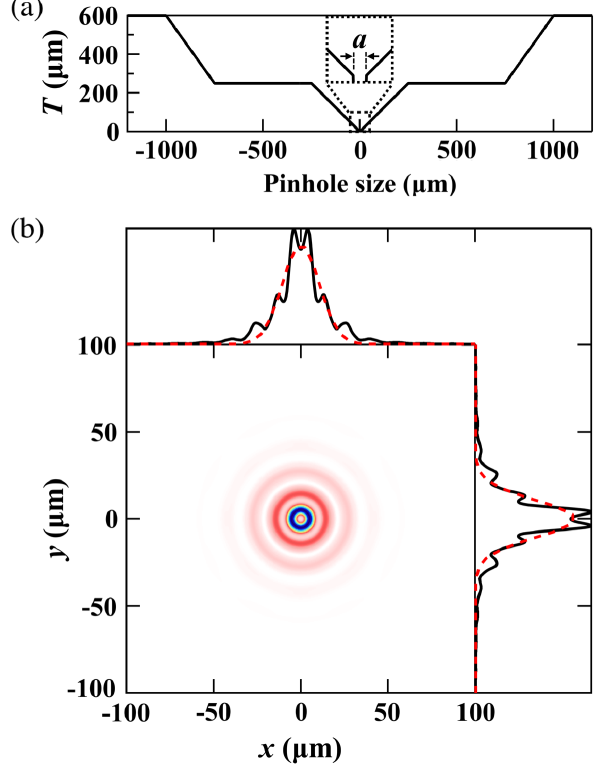
FIG. 3. (a) Thickness profile of the pinhole cross section. (b) Simulated pinhole PSF at 20 keV (left-bottom panel) and the integrated PSF functions (solid curves) along the x (top panel) and y (right panel) directions, respectively, with the Gaussian fitting shown as dashed curves. The pinhole diameter is 20 μ m. ¼ 8 . 4 μ m. The 1D Gaussian fit of The 2D Gaussian fit gives σ pin ¼ 11 μ m. the integrated PSF gives the projected values of Σ pin